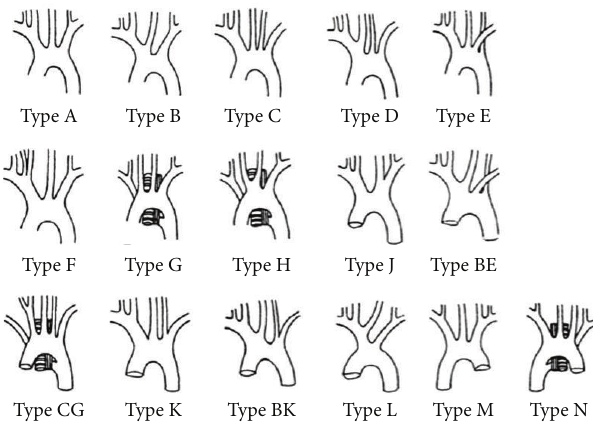
Figure 5: A schematic drawing of aortic arch branch classifications by Adachi, Williams, and Nakagawa. Cited from Williams et al.